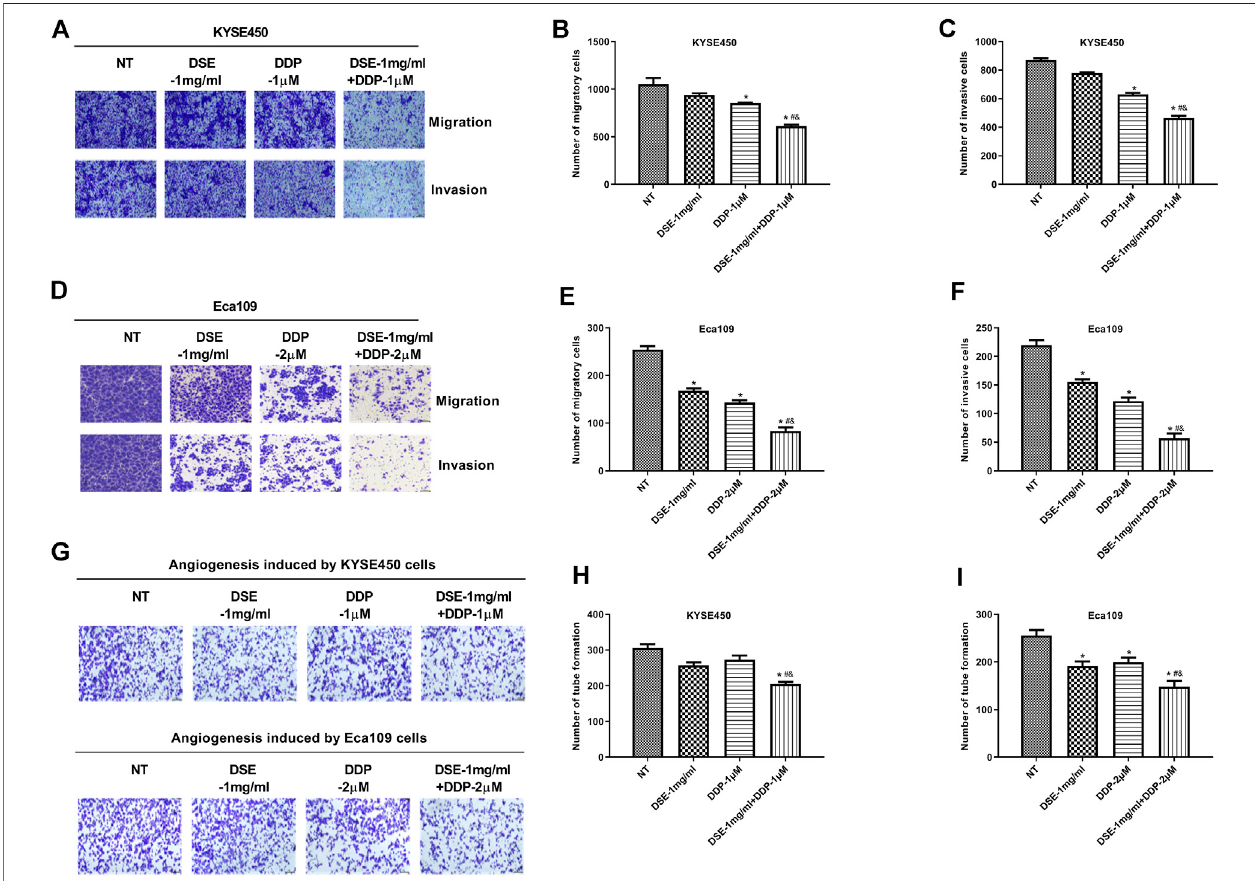
FIGURE 9 | DSE combined with DDP inhibits migration, invasion and angiogenesis of human ESCC cells. (A – C) Effects of the combination of DSE and DDP on migrationandinvasionofKYSE450. (D – F) EffectsofthecombinationofDSEandDDPonmigrationandinvasionofEca109cells. (G – I) EffectsofthecombinationofDSE and DDP on angiogenesis of KYSE450 and Eca109 cells. Representative images were taken. Scale bars, 100 µm. All data are expressed as mean ± standard deviation ( n = 3). * p < 0.05 vs. NT group. # p < 0.05 vs. DSE group. & p < 0.05 vs. DDP group. NT: No treatment.